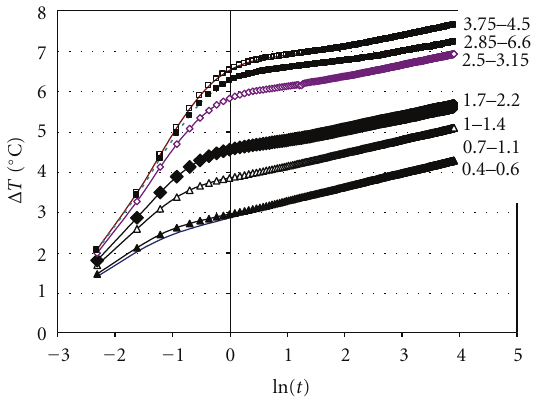
Figure 4: Example of the evolution of the slopes ( a 1 , a 2 ) of the Δ T/ ln( t ) curves for the successive S glass-bead assemblages. The wire temperature increase was measured using a 300 mA current.